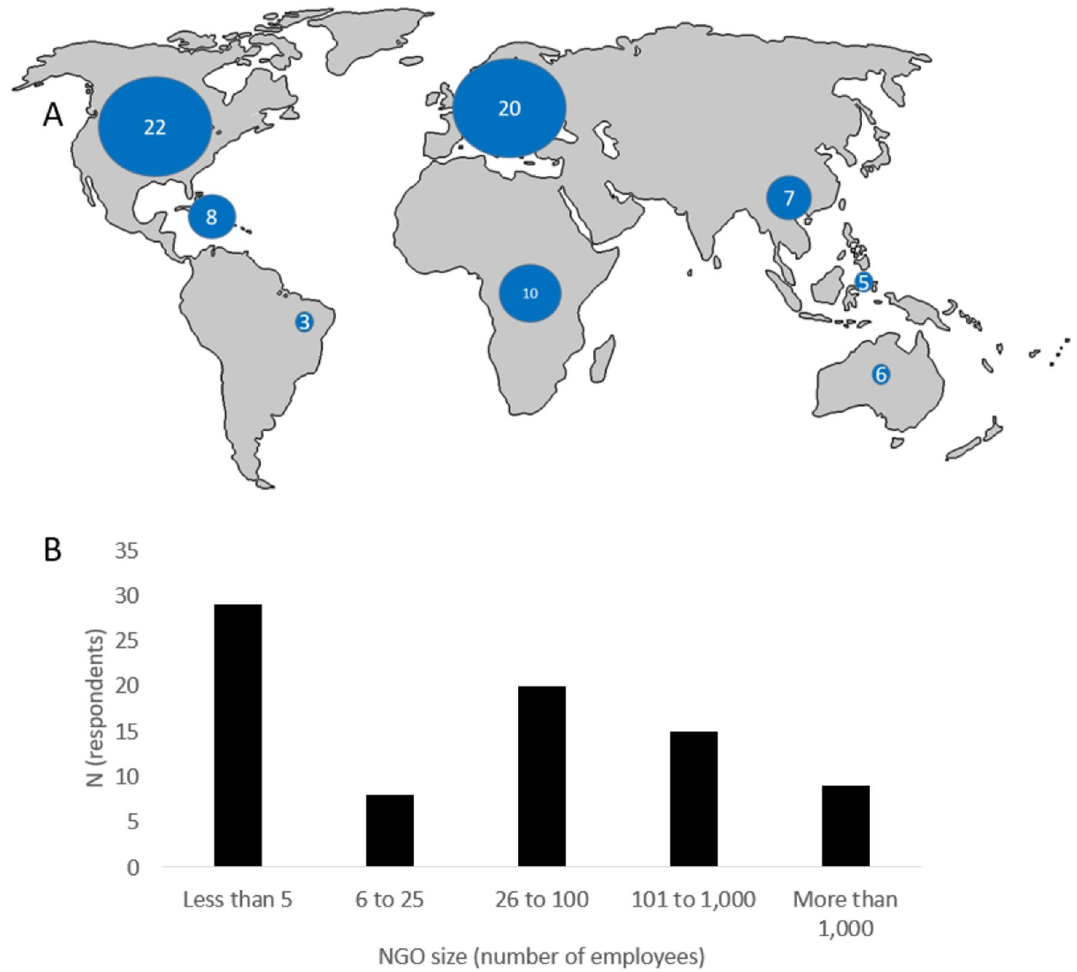
Figure 1. ( A ) Where respondents primarily work, excluding those who responded with “worldwide,” with bubbles scaled using PowerPoint ( B ) distribution of the size of non-profits (by number of employees) that respondents self-report working